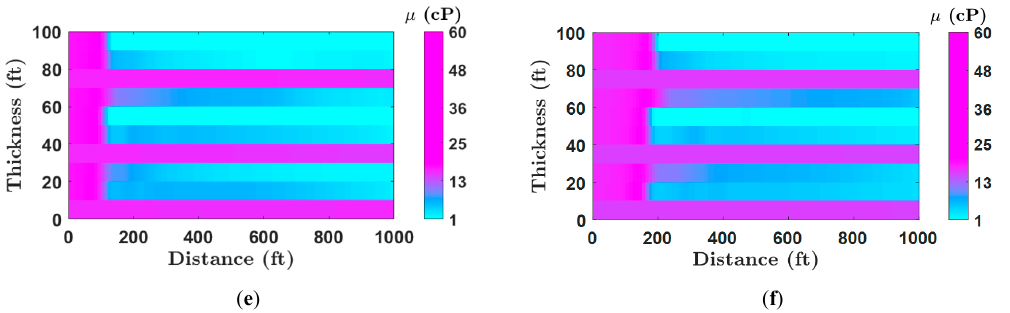
Figure 8. Polymer concentration ( a , b ), salinity ( c , d ), and aqueous phase viscosity ( e , f ) profiles for the test case using the continuous polymer flooding scheme at t D = 1.3 ( a , c , e ) and t D = 1.7 ( b , d , f ).